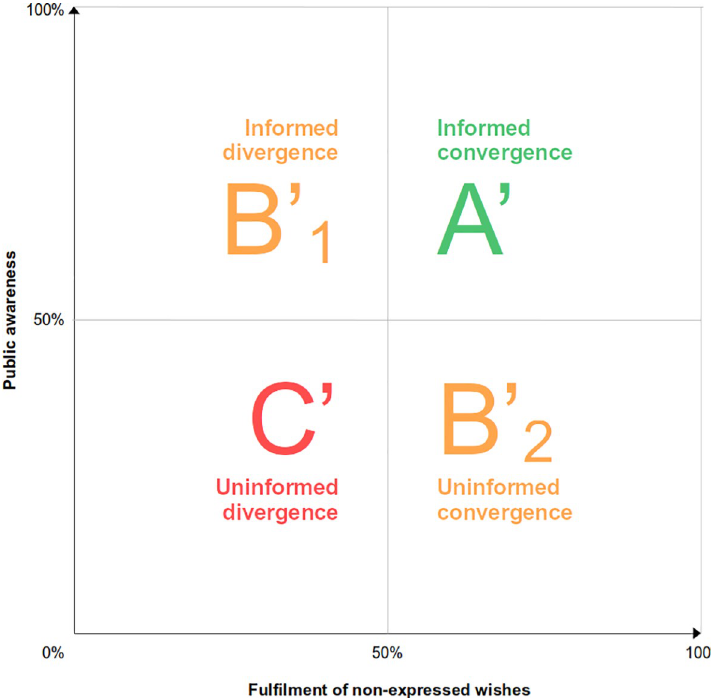
Fig 2. Relation of level of knowledge and the fulfilment of non-expressed preferences for organ procurement.